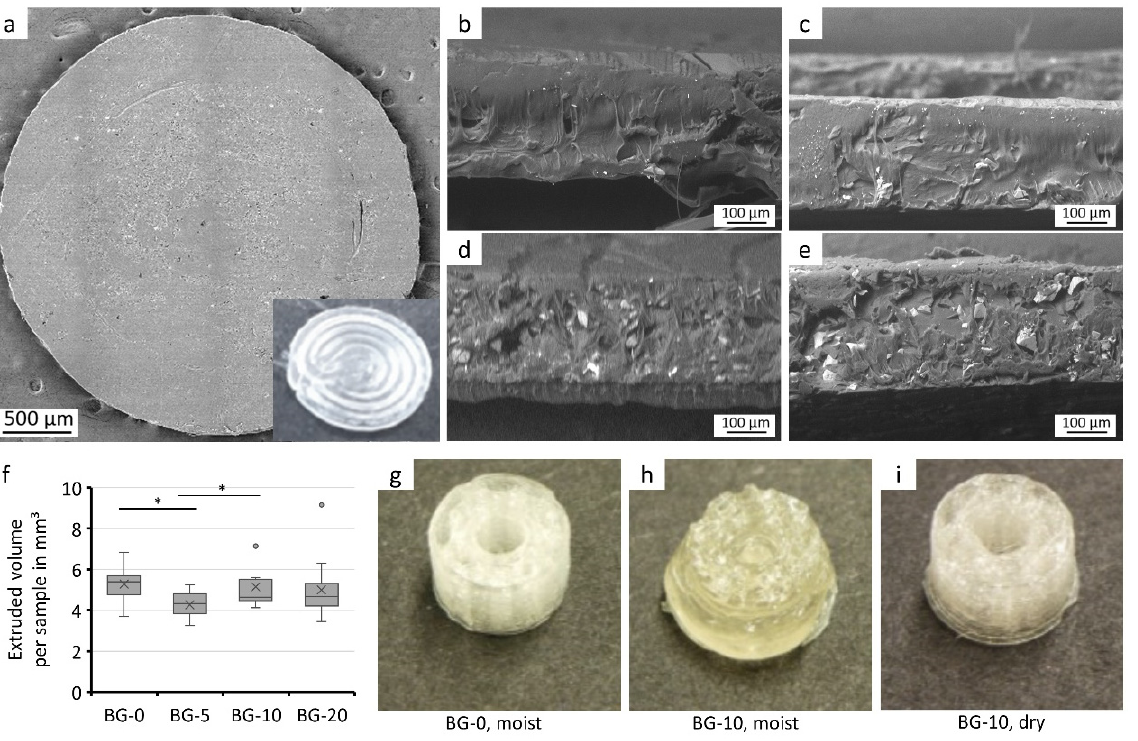
Figure 3. Composite filament processing via FFF. SEM and photographic image of a simple cylindrical structure printed via FFF with two layers ( a ). SEM images of the cross section of the cylindrical structure printed with BG-0 ( b ), BG-5 ( c ), BG-10 ( d ) and BG-20 ( e ). Extruded volume per cylindrical structure, calculated using the weight and the respective bioglass contents of the composite filaments ( f ) ( n ≥ 12, * indicates significant differences of p < 0.05). Design printed with moist filament without ( g ) and with bioglass content ( h ) and printed with dried filament with bioglass content ( i